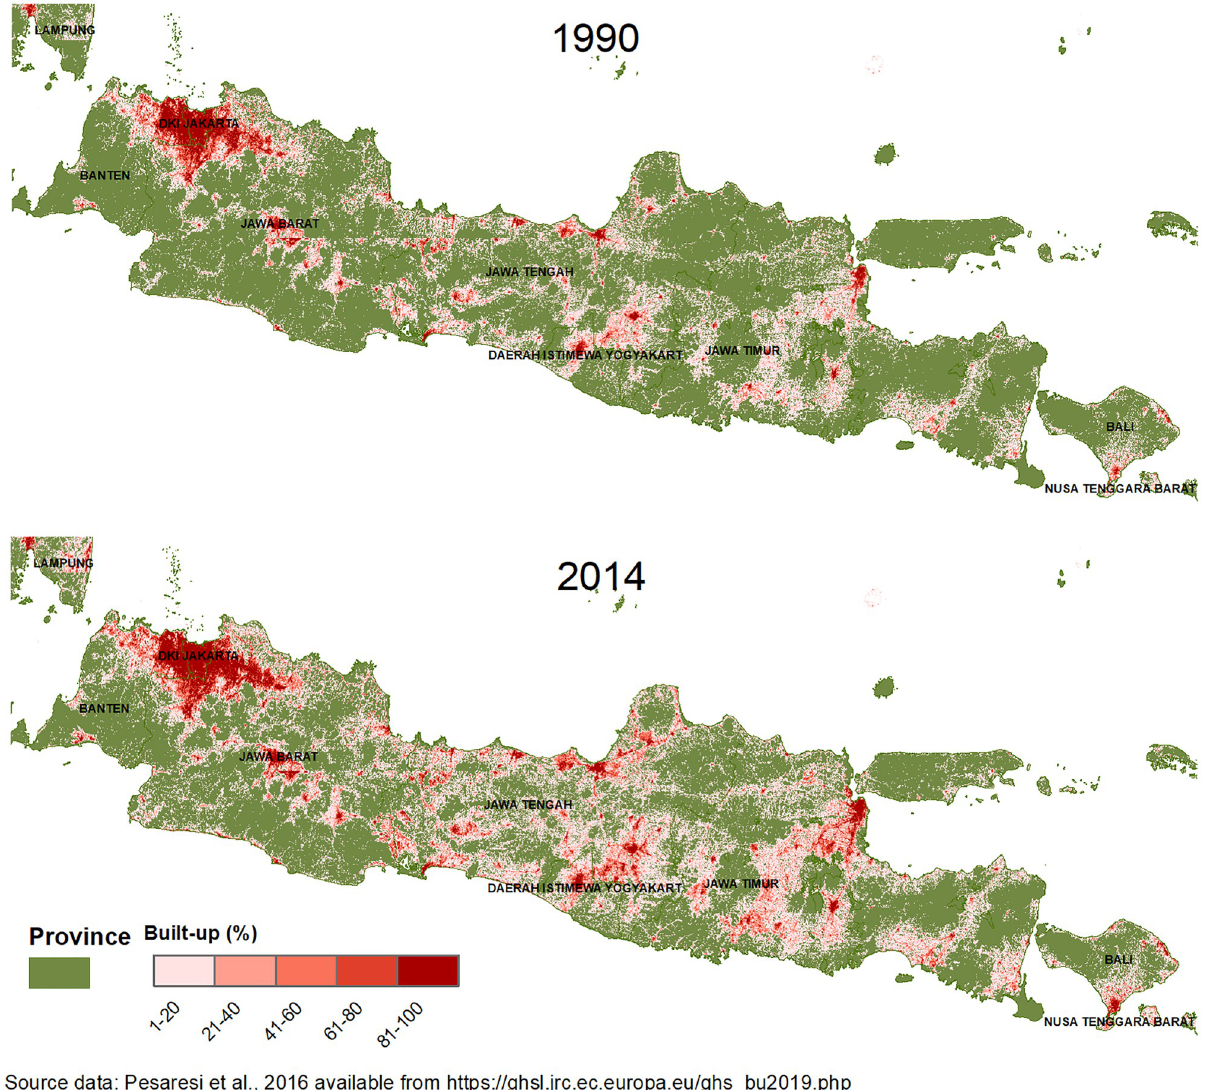
Fig 2. Indonesia provinces and Global Human Settlement Layer (GHS) data, Built-up Land Area (%), Java close-up, 1990–201. Source data: Pesaresi et al., 2016 downloadable from: https://ghsl.jrc.ec.europa.eu/ghs_bu2019.php.